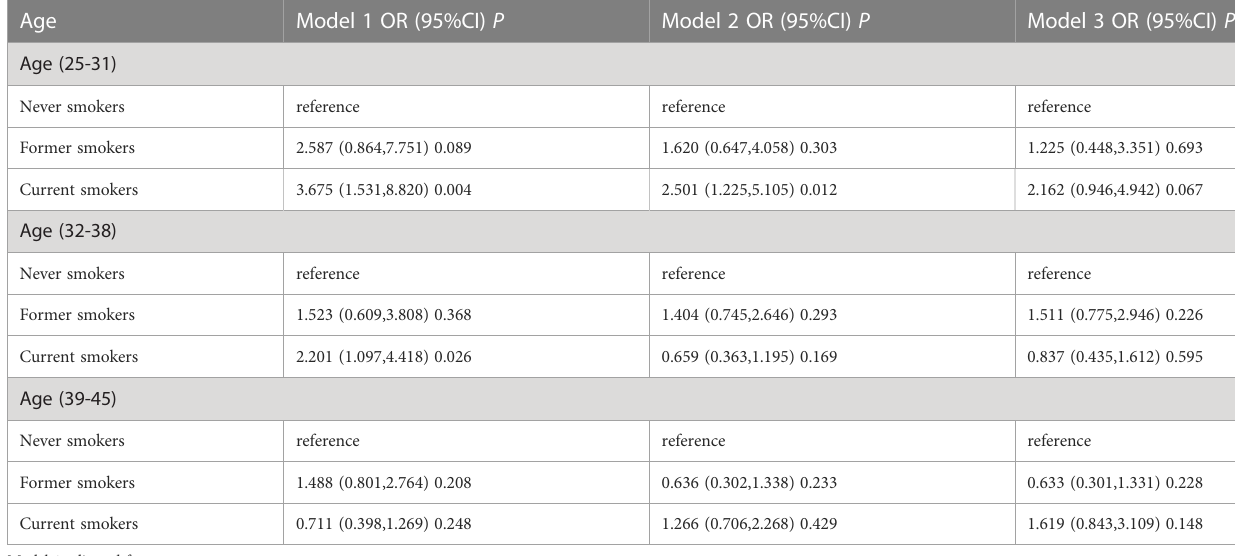
TABLE 4 Association between smoking status and infertility strati fi ed by